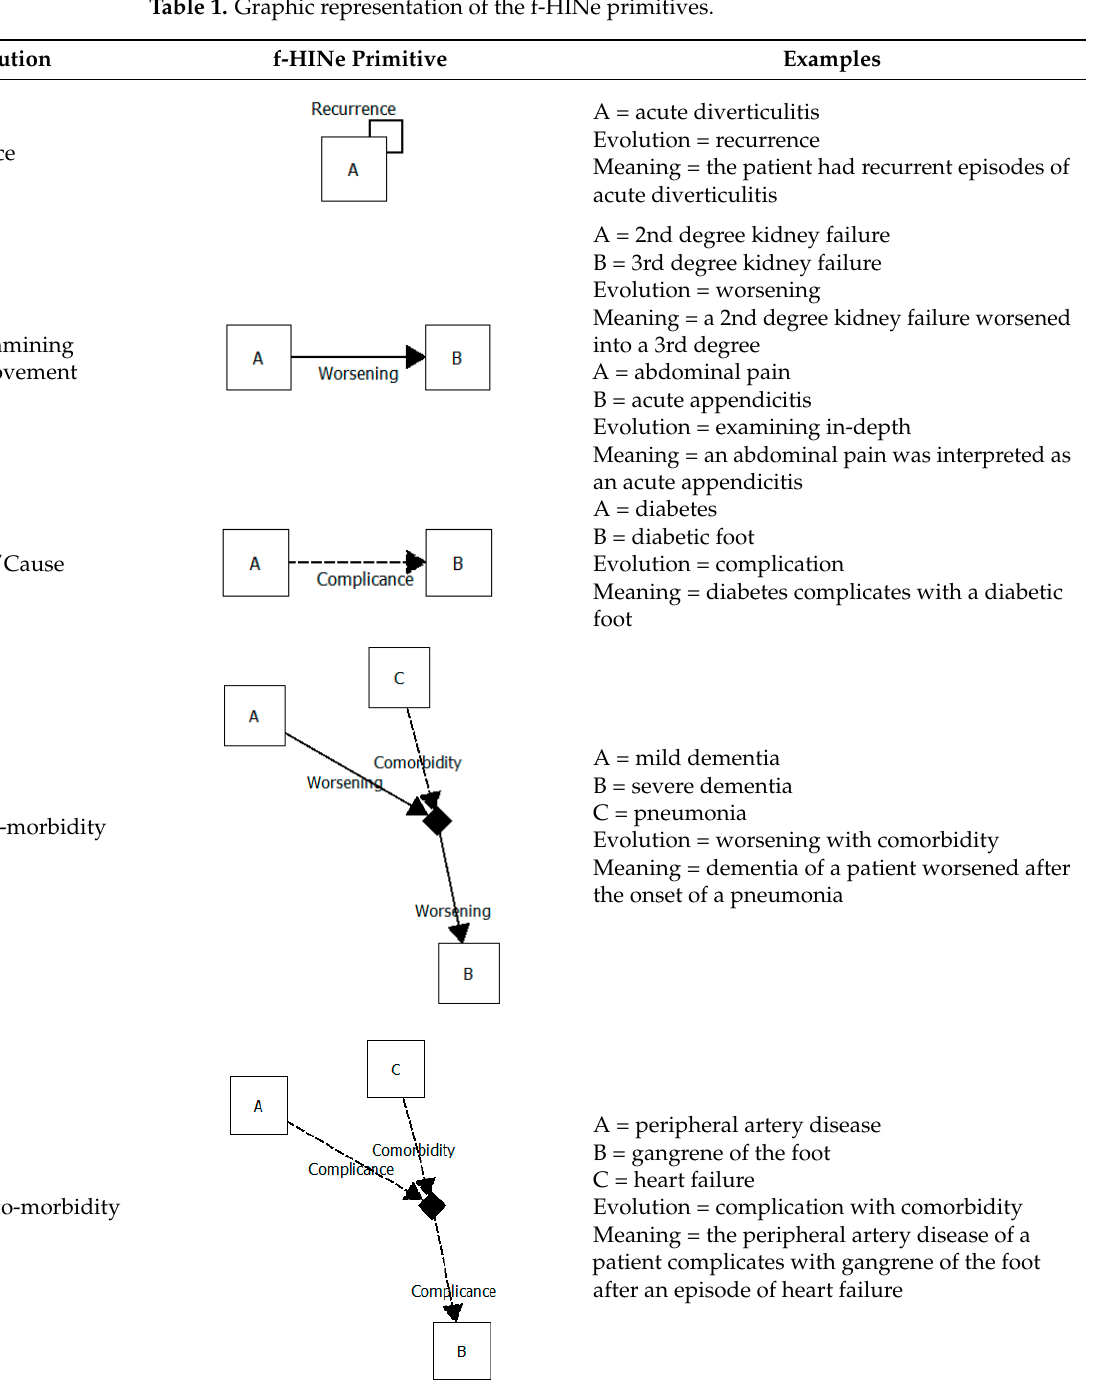
Table 1. Graphic representation of the f-HINe primitives. Type of